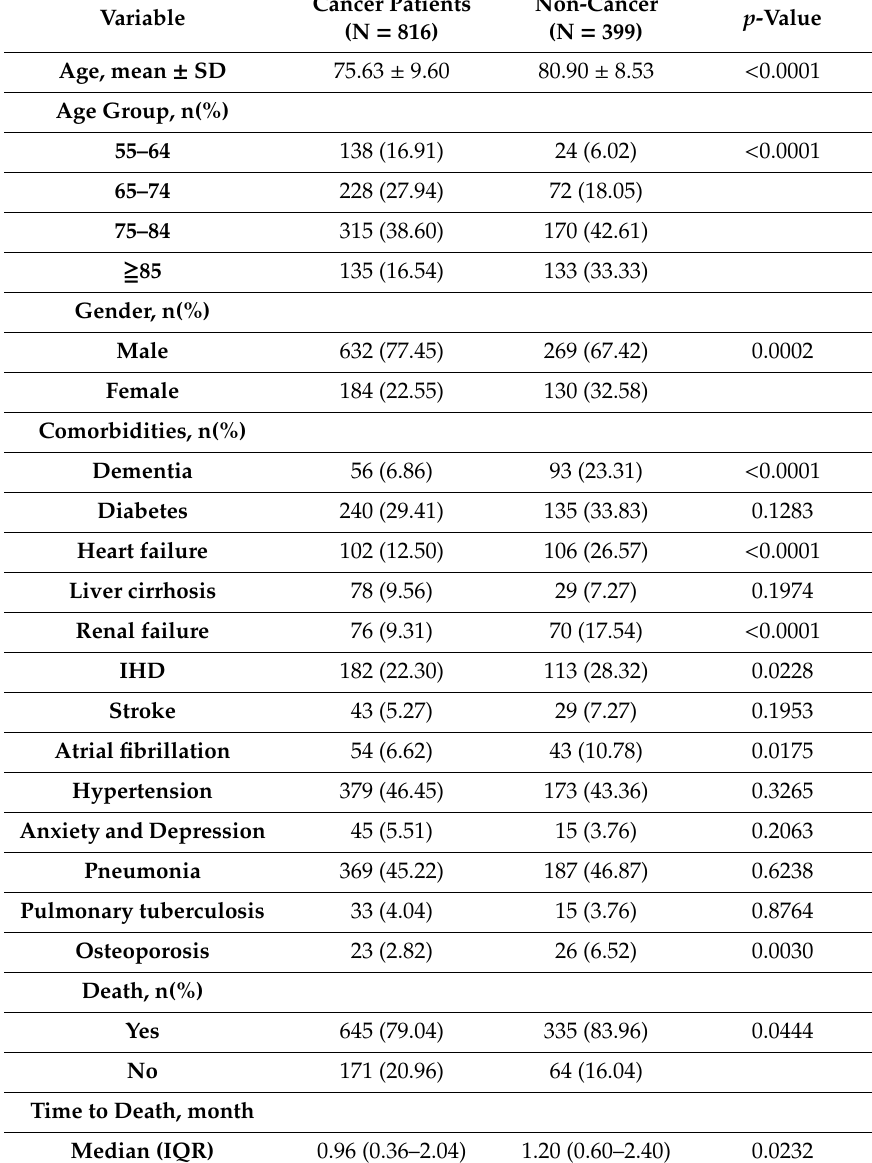
Table 1. Demographic characteristics of COPD patients with and without cancer receiving PC.